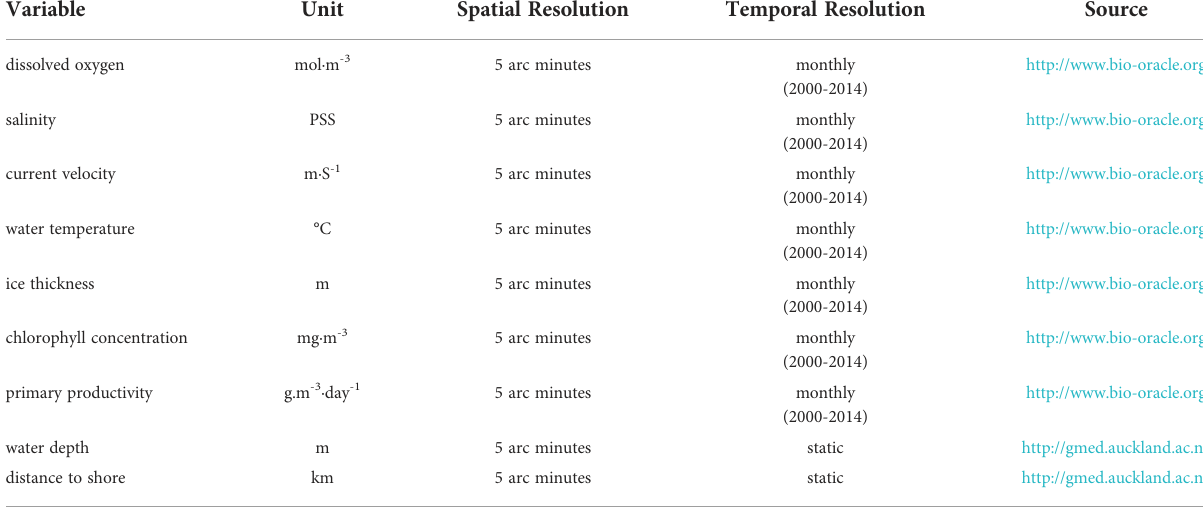
TABLE 2 The nine environmental variables initially selected for this study and their units, spatial resolution, temporal resolution and sources. Variable